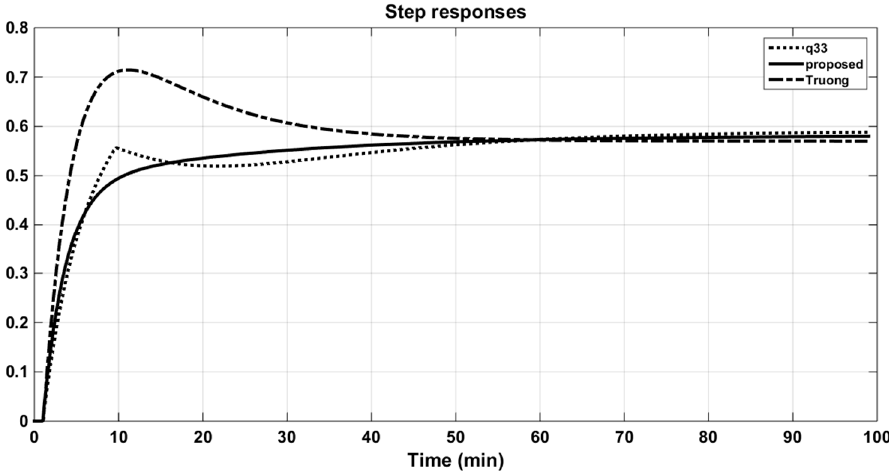
Figure 20. Step responses of the original q 33 and its approximations (OR column).